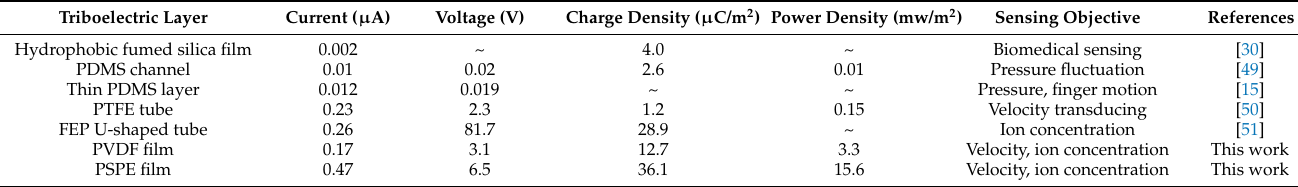
Table 2. The comparison of liquid-solid TENG regarding the output performance and sensing